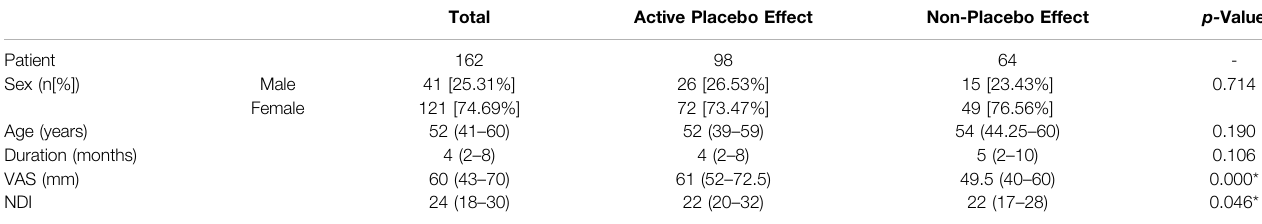
TABLE 1 | Summary of demographic information of the patients in different placebo